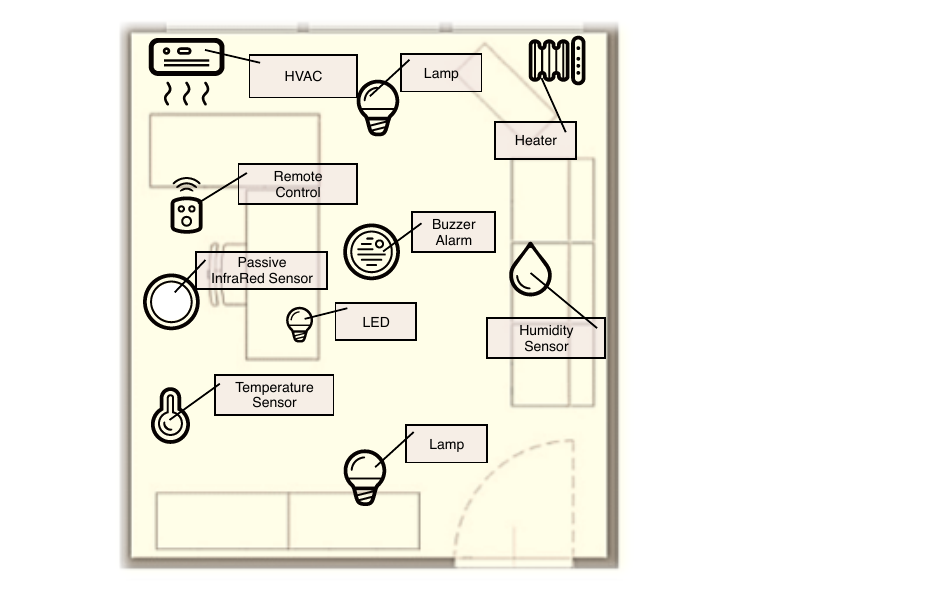
Figure 1. A possible reference application scenario. The physical domain is composed of objects interacting with the